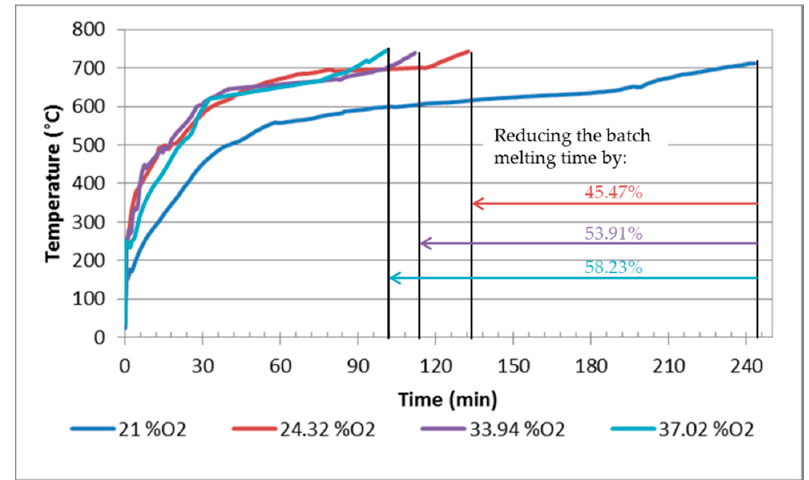
Figure 9. Temperature of the charge during the process of aluminium ingot melting as a function of the oxygen concentration, using the optimised air nozzle.